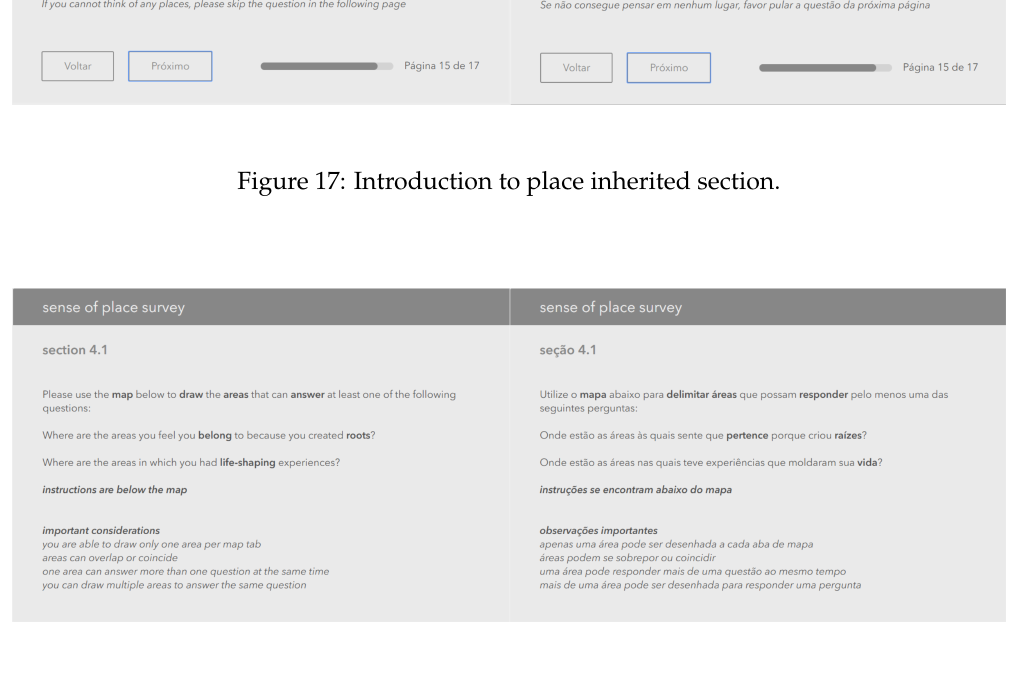
Figure 18: Map-based question for place